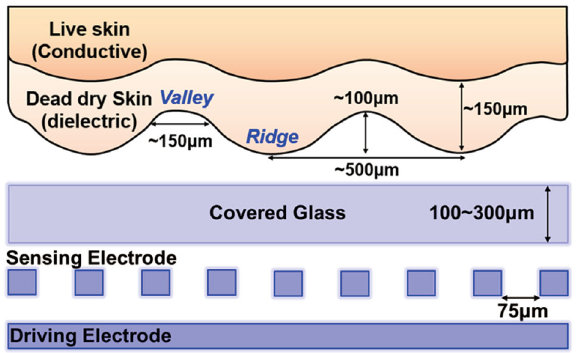
Fig. 14 Detailed fi ngerprint image and the sensing and driving electrodes of the fi ngerprint touch screen